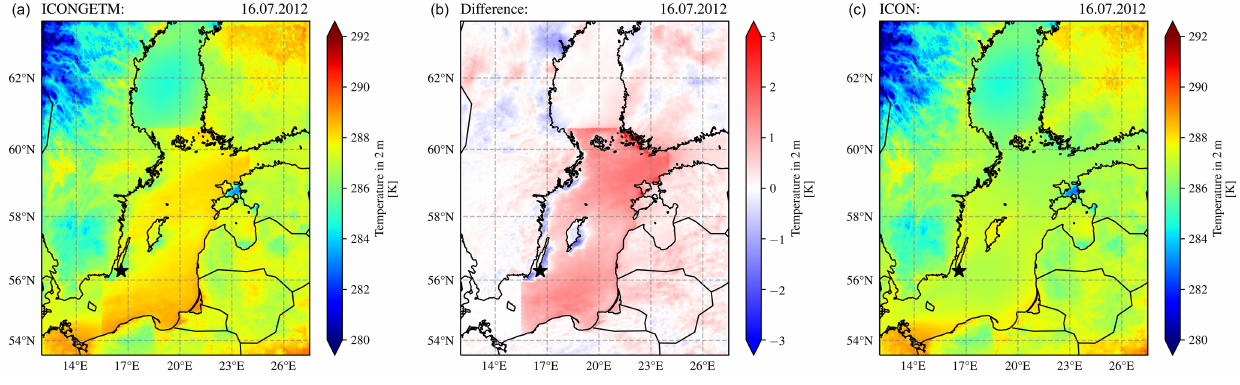
Figure 8. Daily mean 2m air temperature from the two-way coupled ICONGETM simulation (a) and the uncoupled/one-way coupled ICON simulation (c) as well as the difference ICONGETM minus ICON (b) for 16 July 2012. The black star south-east of the island of Öland marks the position of the vertical profiles shown in Fig.